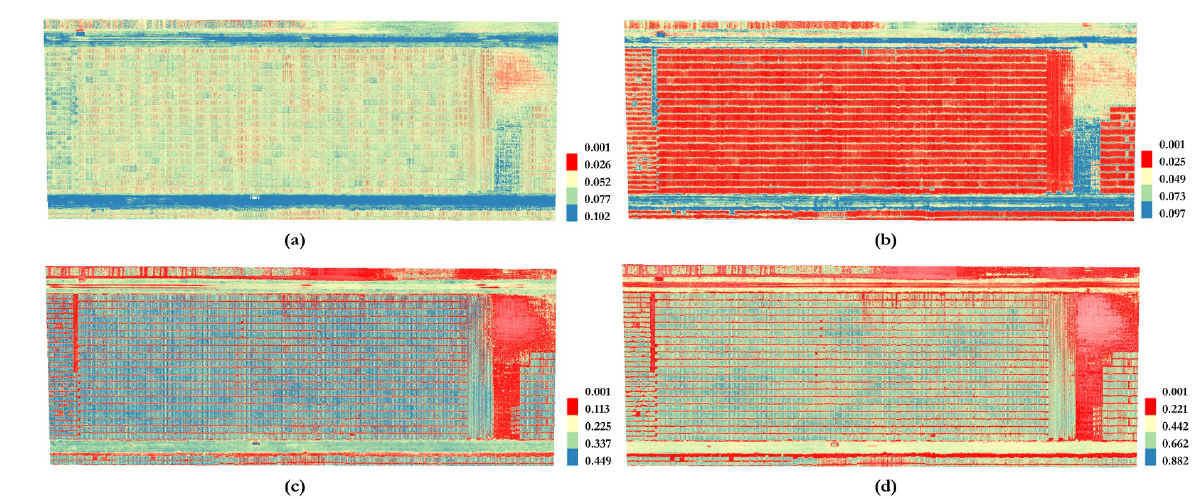
Figure 3. Spectral maps in reflectance (%) by band (DL (500047.3, 4480849.5); UR (500364.0, 4480968.0); EPSG 32616): green (a), red (b), red edge (c) and near infrared